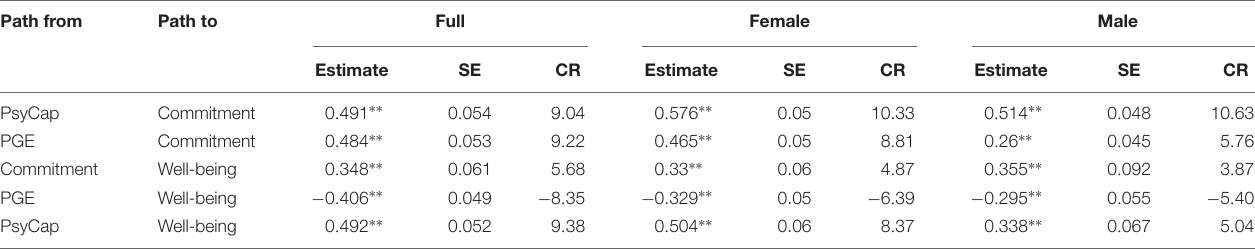
TABLE 5 | Hypothesis testing through regression estimates.